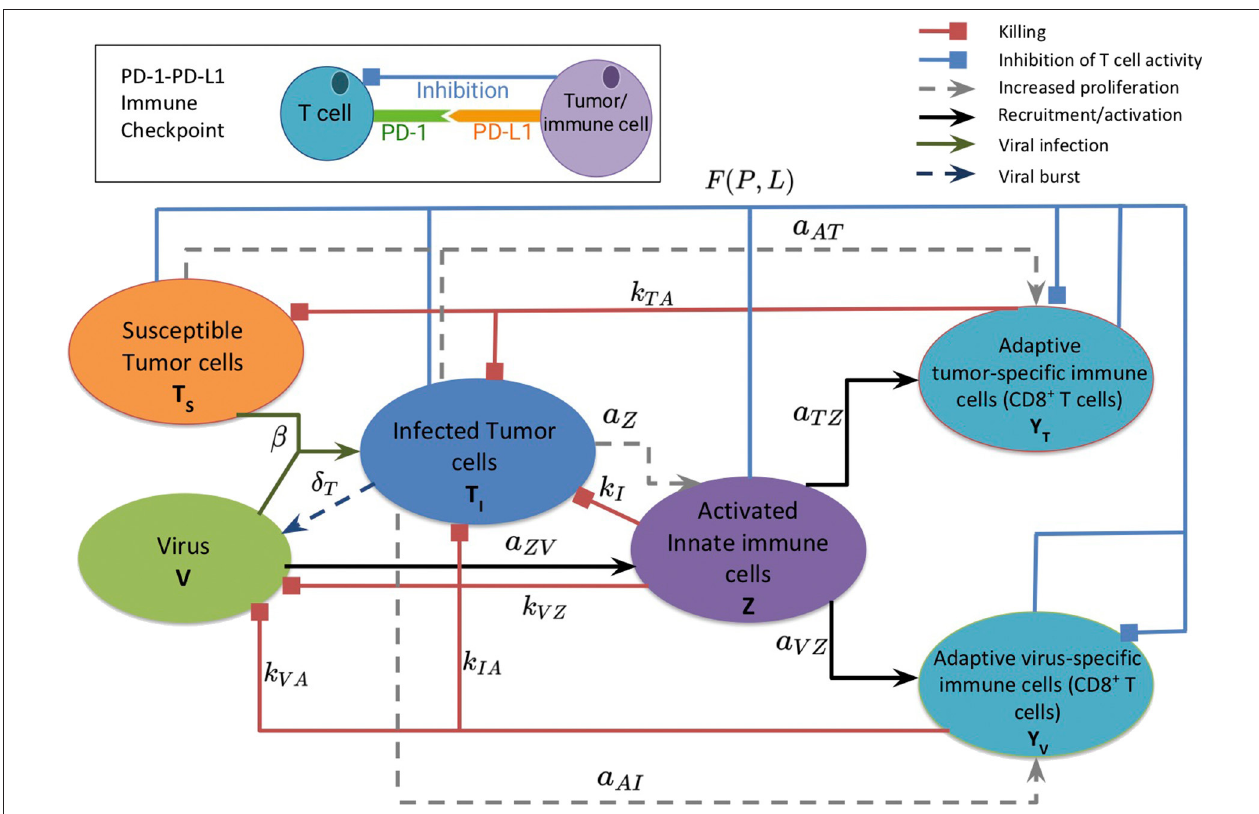
FIGURE 1 | A schematic diagram of the model, depicting the interactions between the susceptible and infected tumor cells, innate and adaptive immune cells, and the virus. Susceptible tumor cells become infected by the oncolytic virus, and following successful viral replication within the infected cells, these cells lyse to give rise to new viral particles. Innate immune cells, representing both macrophages and natural killer cells, become activated when they encounter the virus or viral antigens on the infected cells, and subsequently target and kill viral particles and infected cells. The innate immune cells present viral and tumor antigens to CD8 + T cells, which activate antiviral and antitumor T cells. Antiviral T cells attack and kill infected cells and viral particles, and antitumor T cells target both infected and susceptible tumor cells. The inset diagram displays the inhibition of adaptive immune cell activity by the PD-1/PD-L1 immune checkpoint.